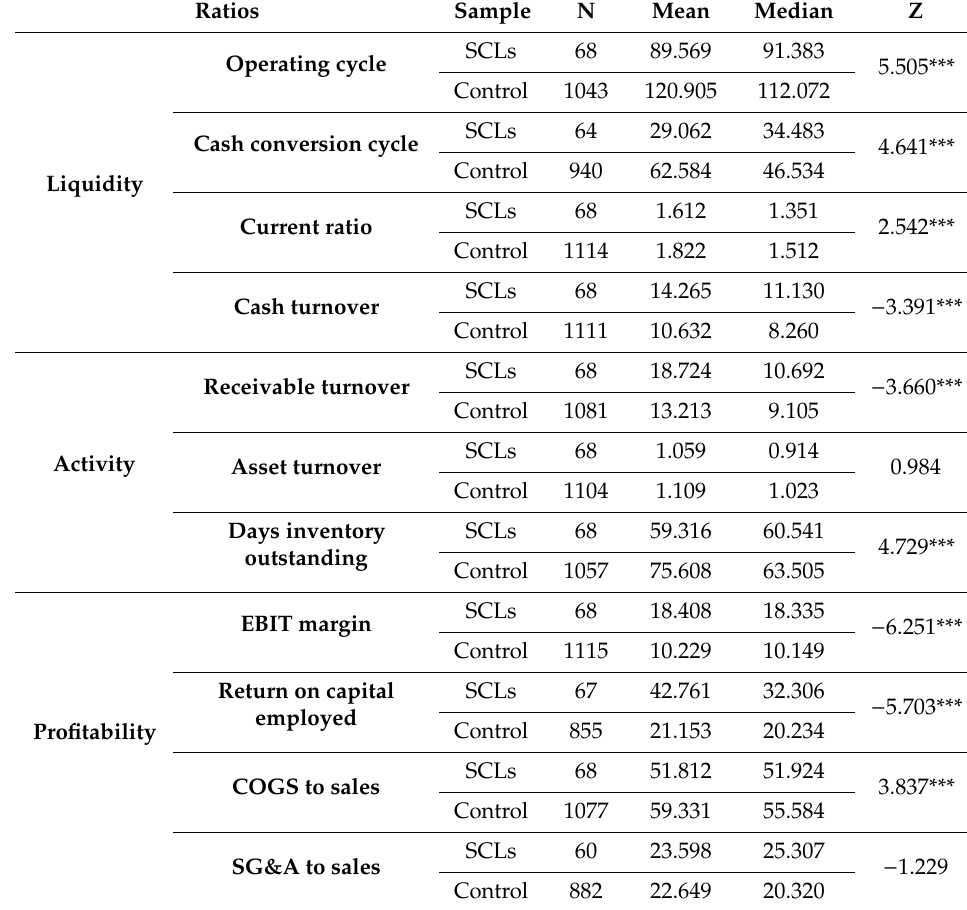
Table 4. Comparison of ratios for SCLs and control